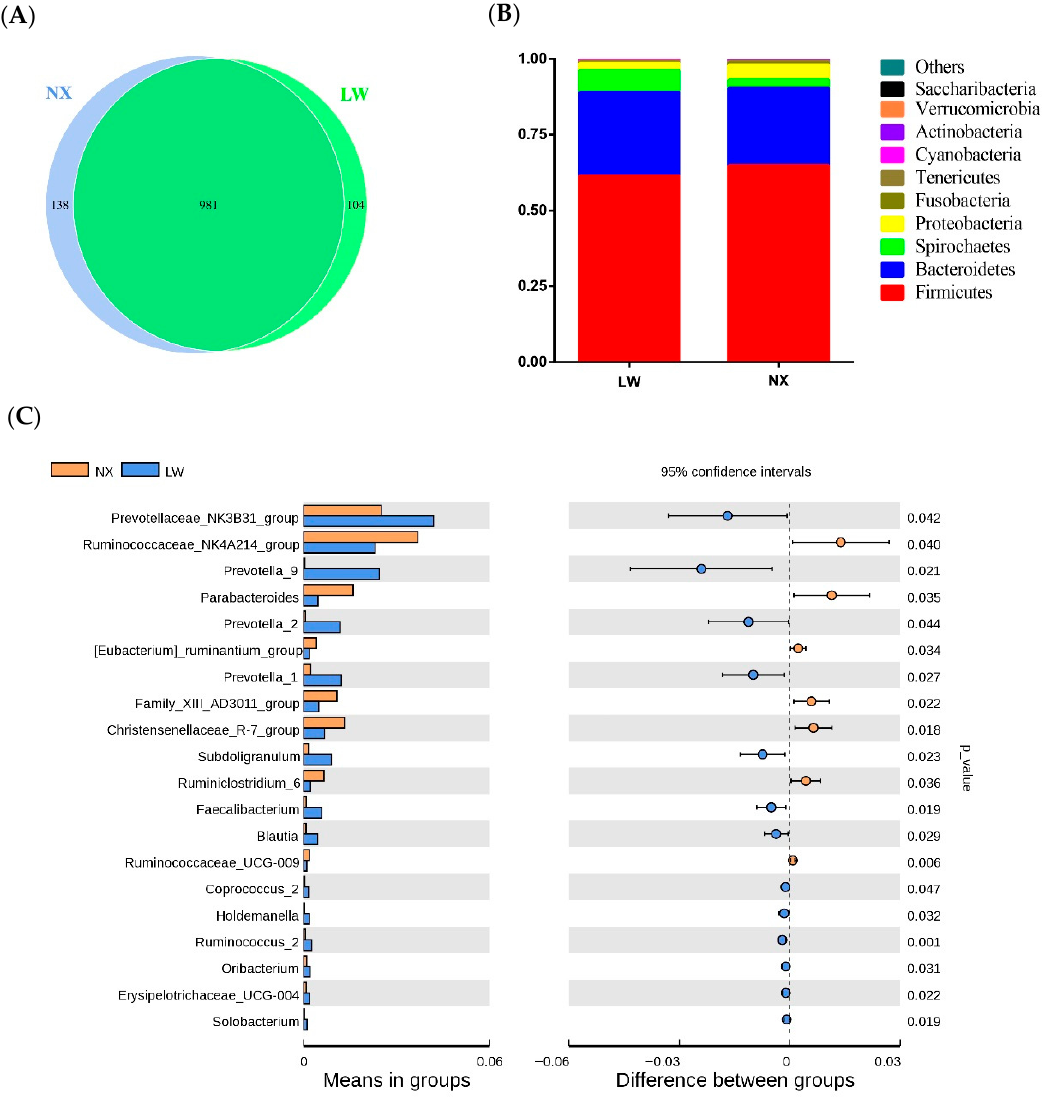
Figure 2. The analysis of colonic microbiota composition. ( A ) Venn diagram showing the coincidence of operational taxonomic units (OTUs) between the two pig breeds. ( B ) Phylum-level comparison of arithmetic mean plot with weighted Unifrac distance of β diversity. ( C ) Relative abundance of microbial genera (percentage) was significantly affected between the two pig breeds. LW, Large White; NX, Ningxiang.